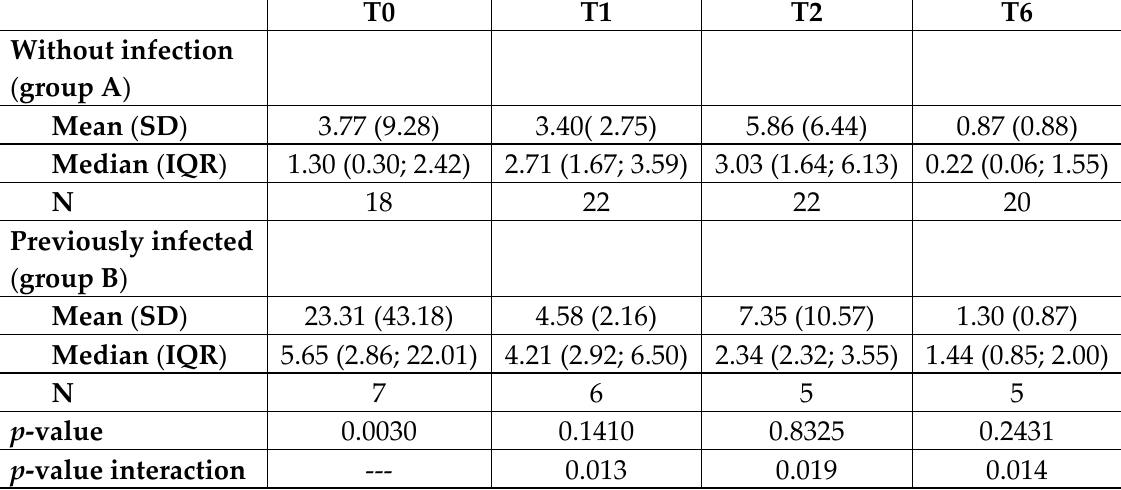
Figure 3. The CD8+ T cell response to Spike peptide megapools ( MPS ) in the two groups of subjects . The data are expressed as Stimulation Index (SI), mean (standard deviation, SD) and median (interquartile range, IQR). p -value between the two groups is analyzed with Mann–Whitney test at each timepoint.